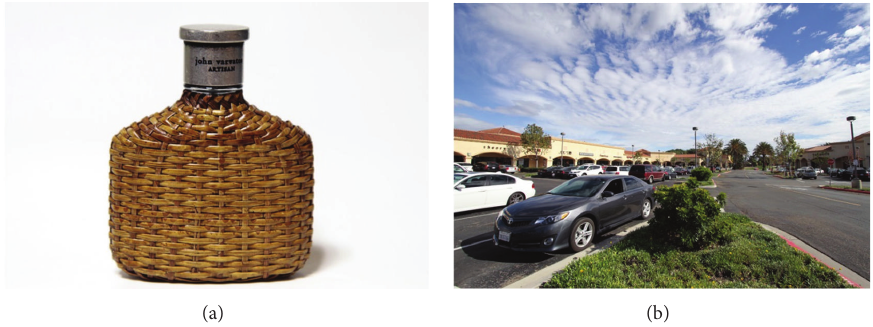
Figure 1: An example of images: an image contains single object (a) and an image contains multiobjects (b).